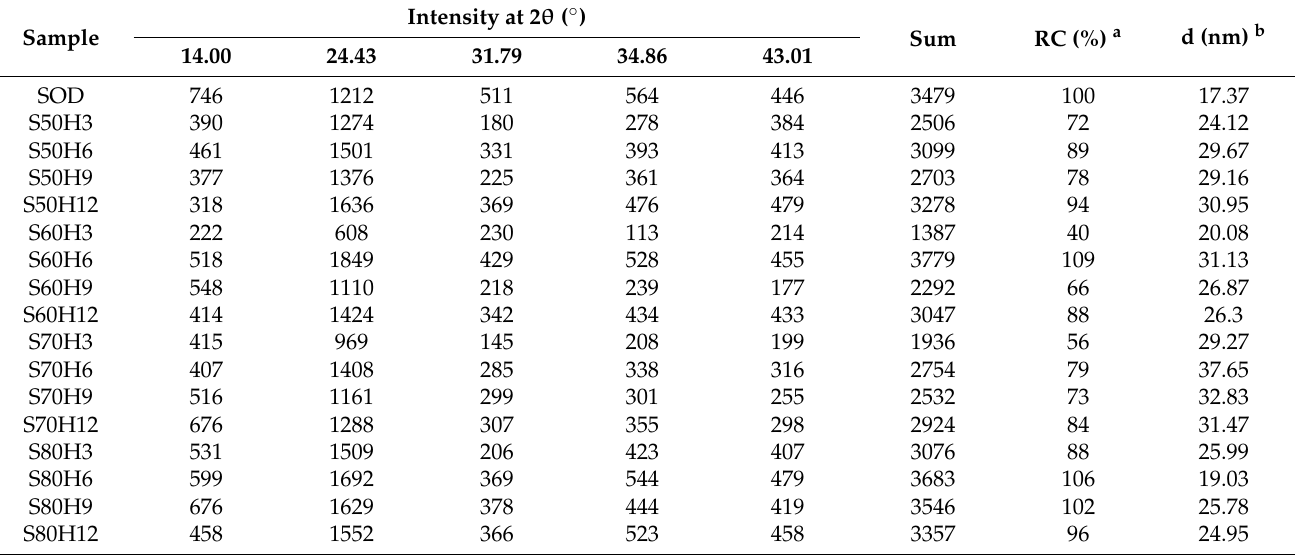
Table 2. Crystallinity of samples based on the XRD